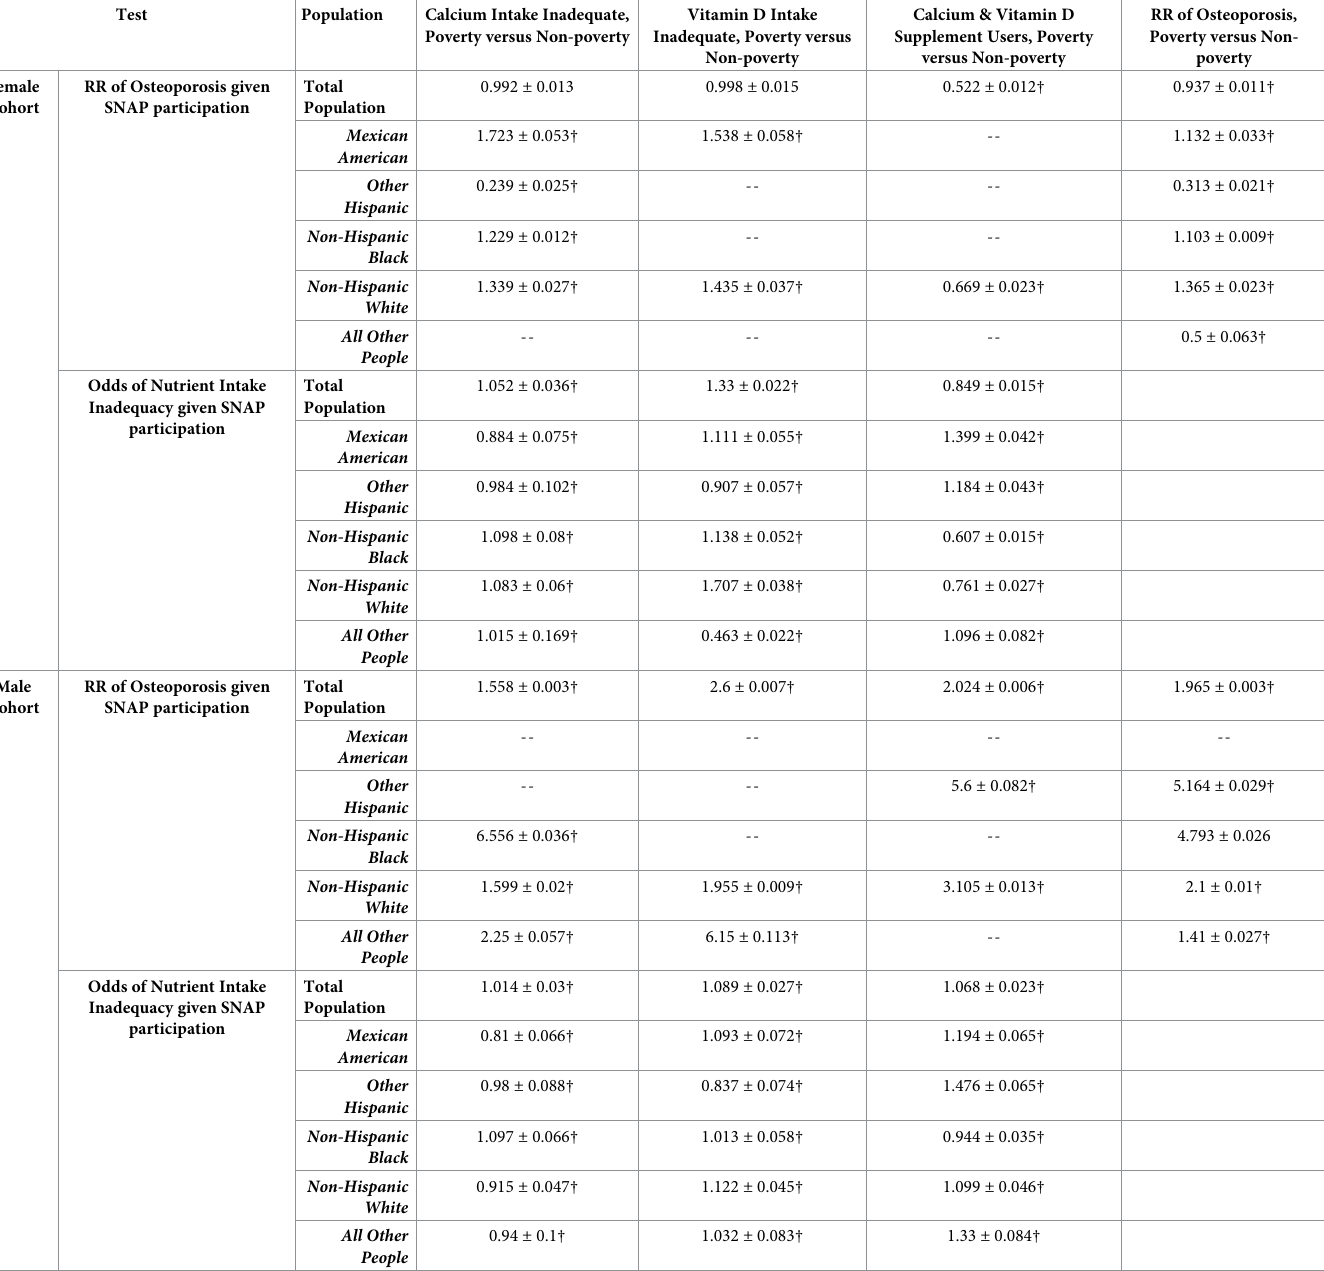
Table 6. Influence of SNAP participation on RR of nutrient intake & osteoporosis with analysis by ethnicity and gender, age 50 and